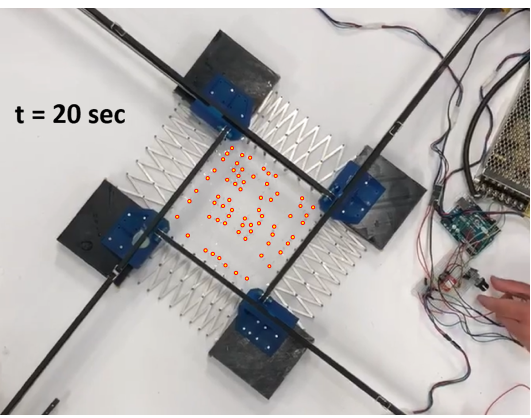
Figure 14. Stretch at 20 s. Red-outlined circles indicate sensor node locations.